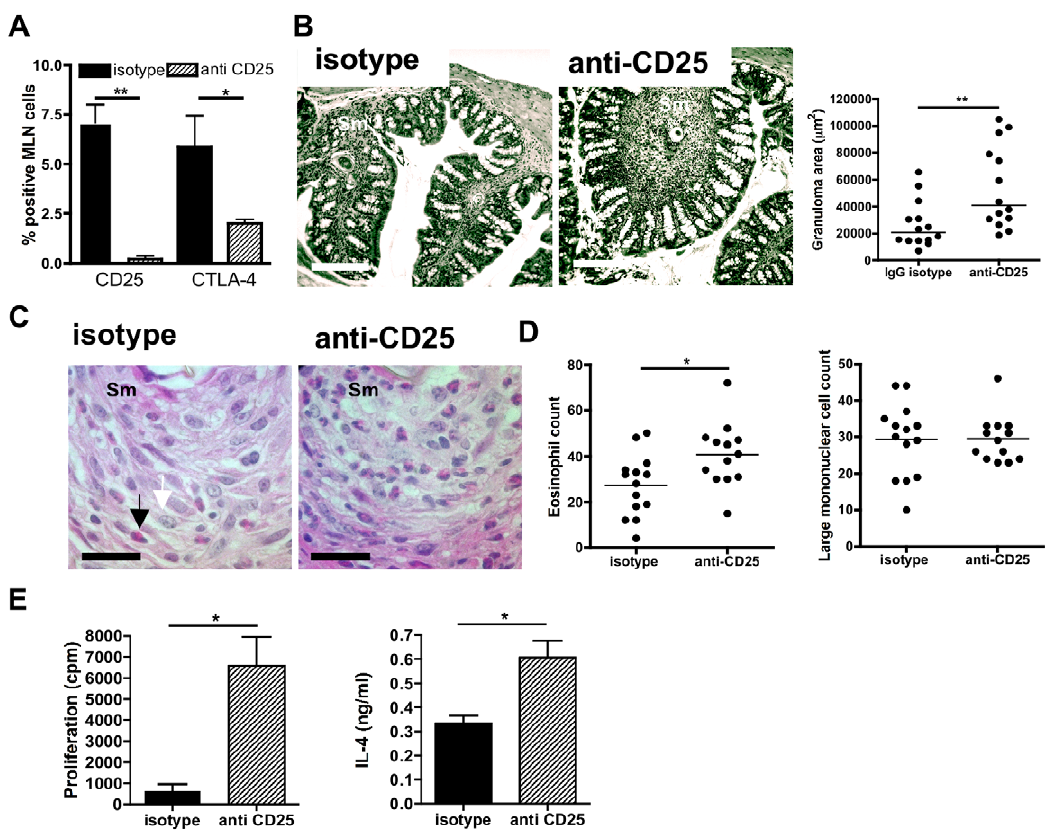
Figure 5. Invivo ablation of CD25 + cells impairs regulation of colonic granulomas and antigen-specific Th2 responses. A ) Percentage of CD25 + or CTLA-4 + mLN lymphocytes from mice with chronic infection after treatment with anti-CD25 mAb, or isotype control. Antibodies given at 2 week intervals from wk 9 to wk 13, tissues sampled at wk 14. Data are mean % positive ( 6 SEM). B ) Photomicrographs of colonic tissue and quantification of granuloma areas after antibody treatment. Scale bar =200 m m; egg denoted ‘Sm’. Data is granuloma area ( m m 2 ) at wk 14 calculated from 3-4 separate histological sections per individual animal (n=4). C) Colonic granulomas (x100) stained with H&E showing eosinophils (closed arrow) and large mononuclear cells (open arrow) in isotype mAb treated (left) and anti-CD25 treated (right|) infected mice. Scale bar =200 m m; egg denoted ‘Sm’. D ) Numbers of eosinophils (left) and large mononuclear cells enumerated from the sections above; Bars are mean cell counts / group (n=4) with 3–4 fields of view / mouse. E ) Antigen-specific mLN responses in anti-CD25 mAb treated mice; data are means of cpm 3 H-thymidine incorporation and IL-4 secretion pg/ml (n=3).